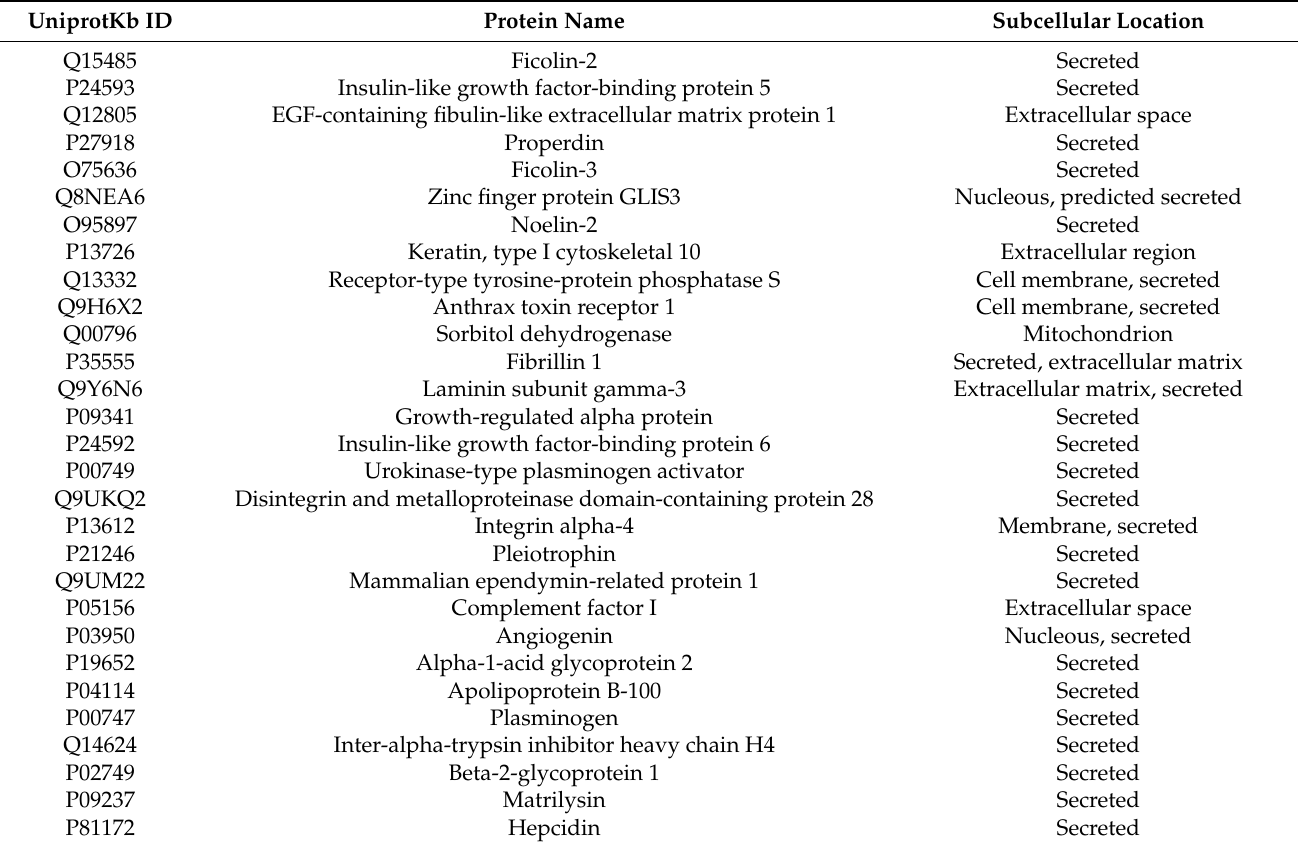
Figure 1. Summary of the in silico biomarker discovery strategy used in the study. ( a ) Layout of the in silico funnel strategy. ( b ) Venn diagrams illustrating the different datasets used to identify candidates satisfying our selection criteria. Table 1. List of the candidate biomarkers identified by the in silico funnel discovery strategy.